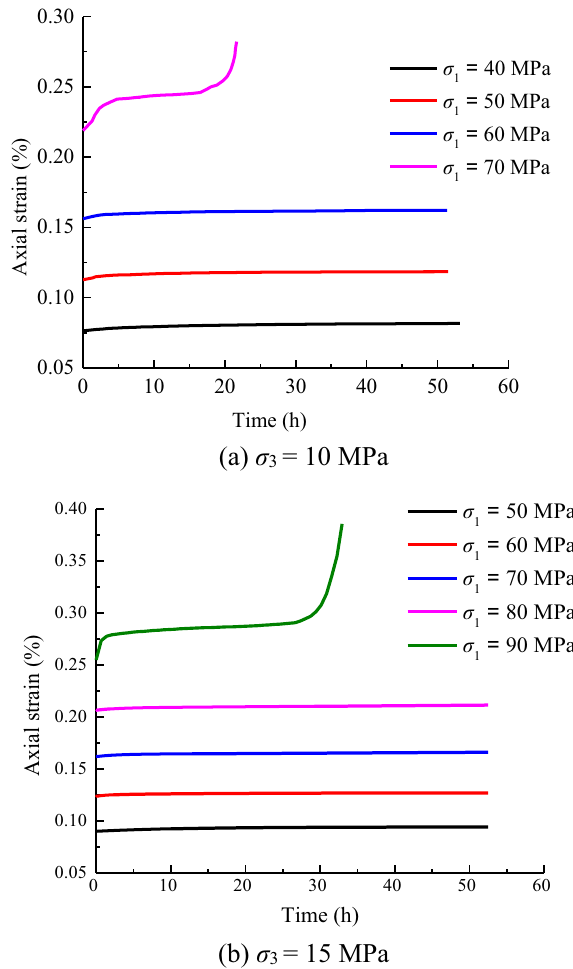
Figure 6. Creep of axial under different axial stress states.